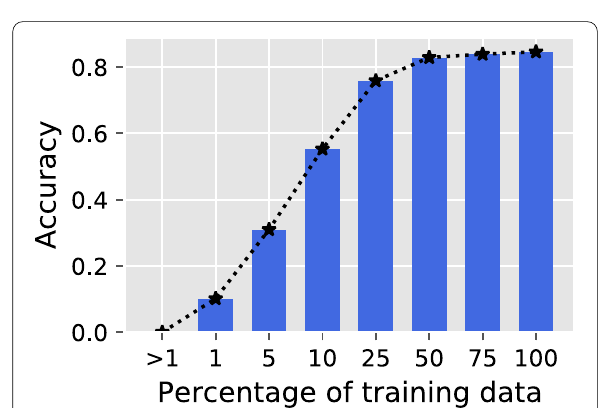
Fig. 6 Overall accuracy as a function of training dataset